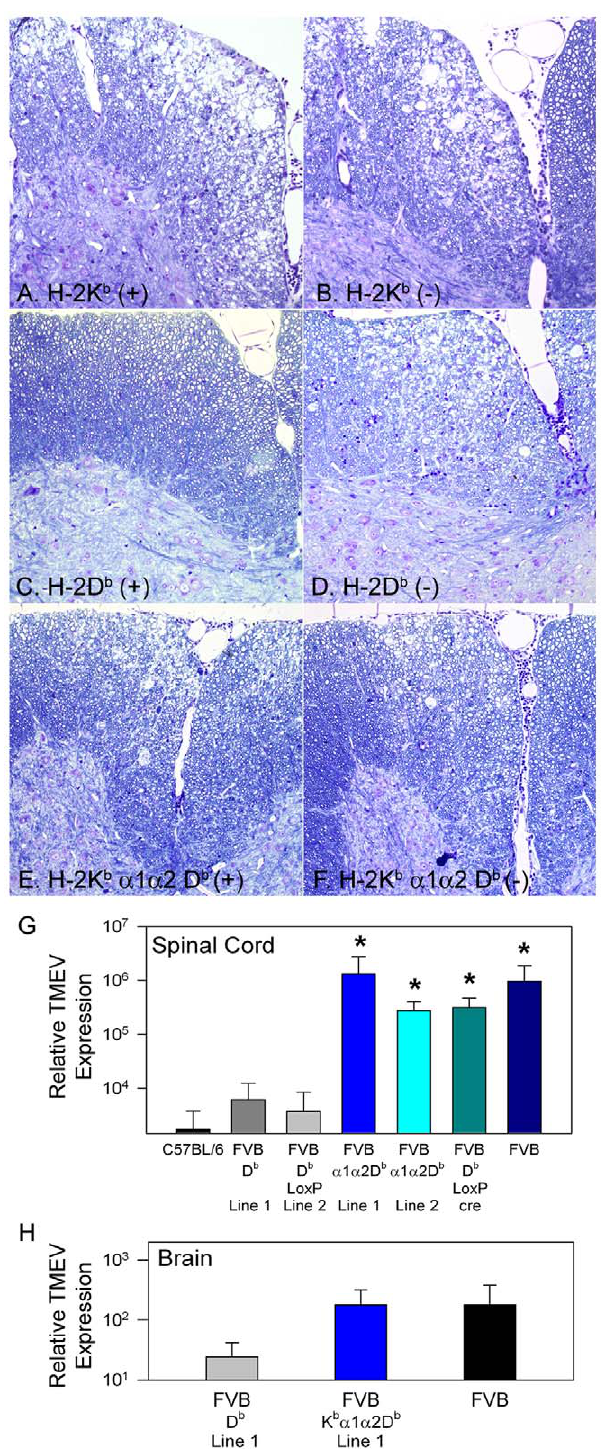
Figure 2. Spinal cord demyelination and persistent virus infection in FVB K b a 1 a 2D b transgenic mice. (A) Transgenic expression of H-2K b fails to protect from TMEV induced demyelination, similar to non-transgenic control (B). (C) Expression of H-2D b transgene protects FVB mice from TMEV induced demyelination present in littermate controls (D). (E) Expression of a chimeric K b a 1 a 2D b molecule fails to protect from demyelination, similar to non-transgenic (F). (G) Relative TMEV RNA levels in spinal cords from transgenic mice infected for 21 days (* p , 0.05 by ANOVA). (H) Relative TMEV RNA levels in the brains of transgenic mice after 24 days of infection.